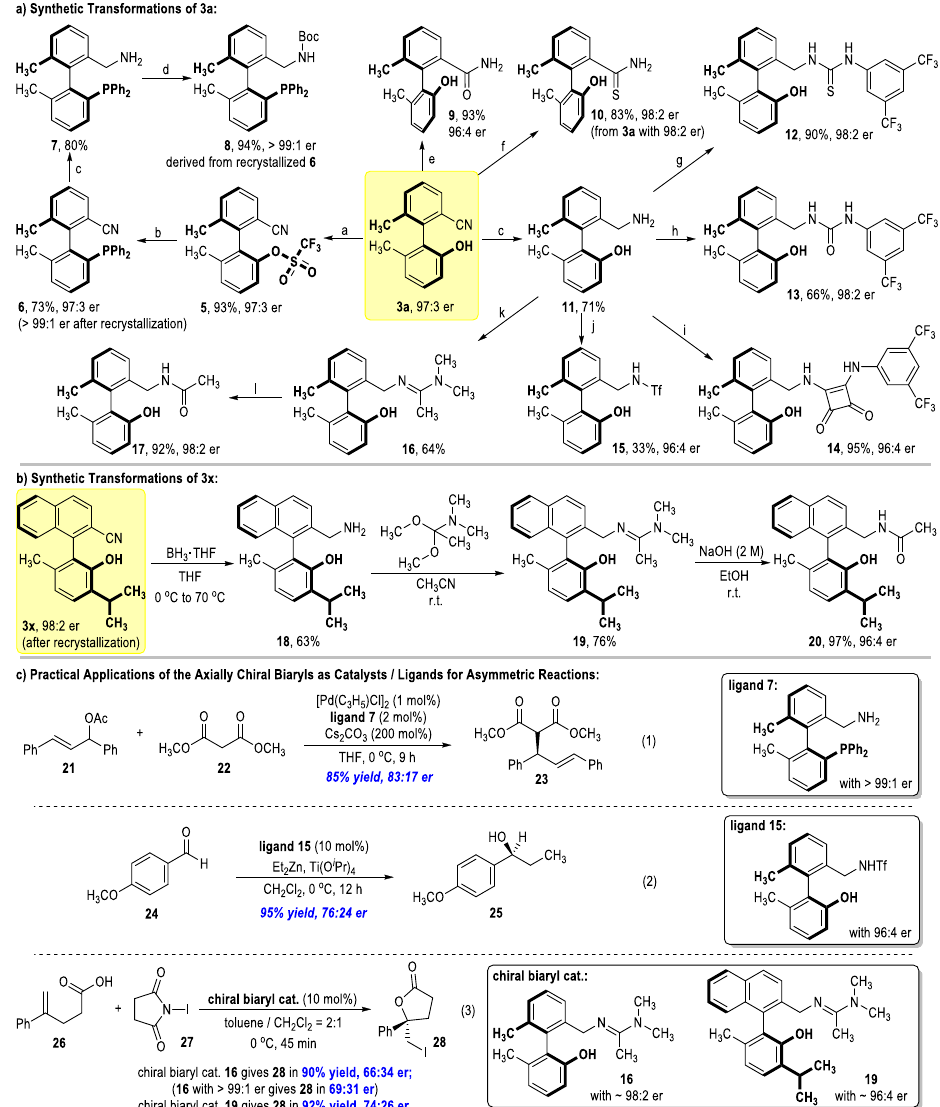
Fig. 4 Synthetic transformations of the axially chiral benzonitriles products and their applications as chiral catalysts/ligands for asymmetric reactions. a Tf b HP(O)Ph 2 O, pyridine, CH 2 Cl 2 , 0 °C to r.t. under N 2 , 2 h; 2 , Pd(OAc) 2 , dppb, DIEA and DMSO at 110 °C under N 2 , 3 h; then HSiCl 3 , DIEA and toluene